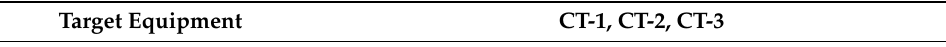
Table 4. Open cooling tower specifications.